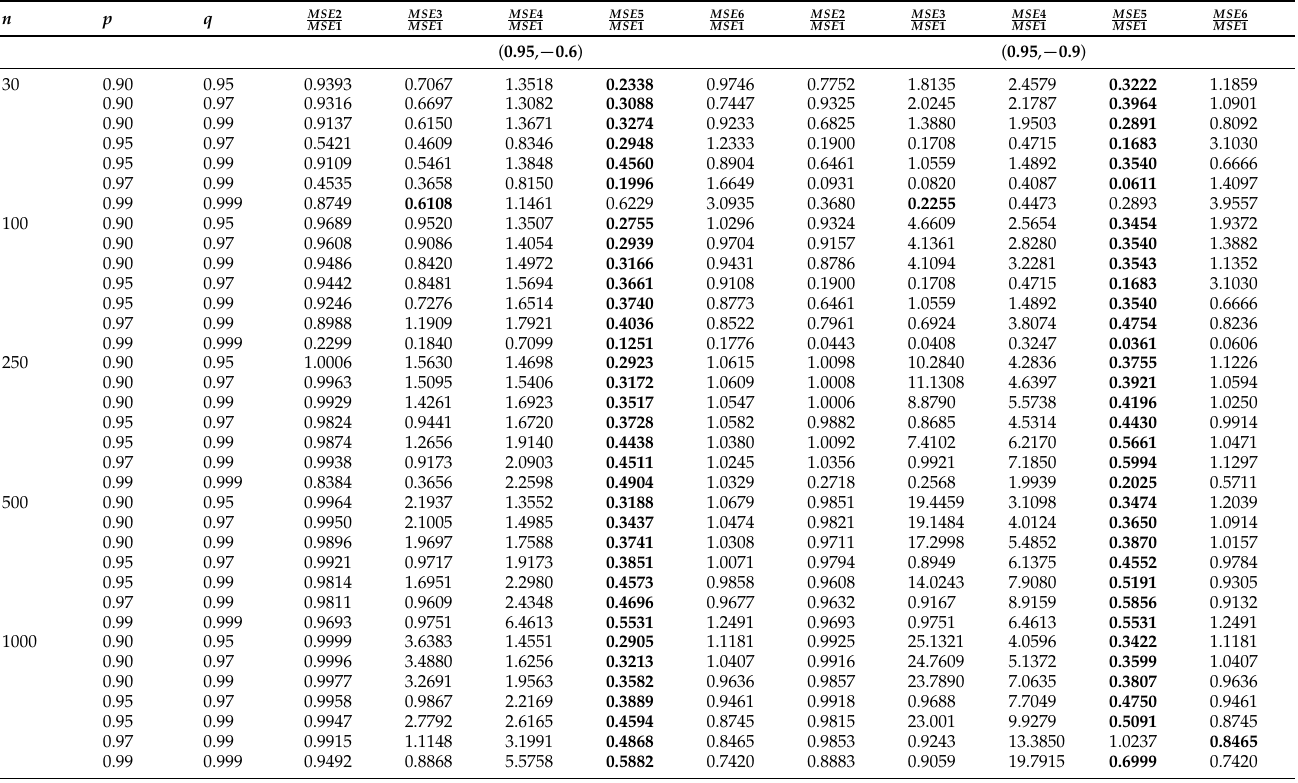
Table 2. Ratios estimated for ARMA model with varying p and q